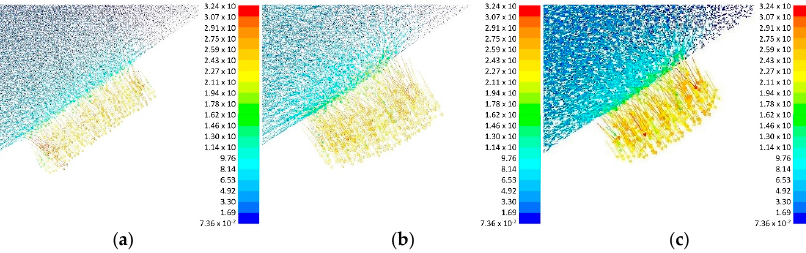
Figure 12. Velocity field for longitudinal orifice at P = 5.0 bar and Q in = ( a ) 10 L/s, ( b ) 20 L/s, ( c ) 30 L/s.